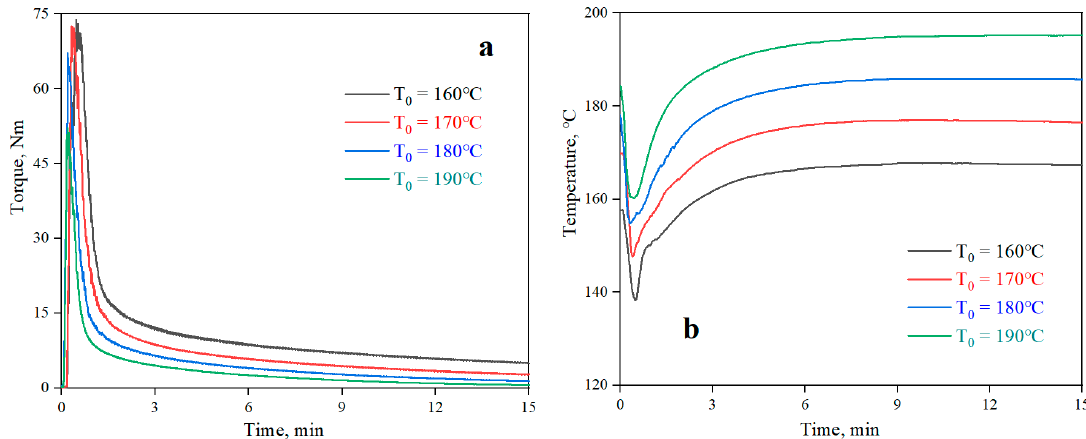
Figure 2. Torque ( a ) and temperature ( b ) versus time when processing the neat PLA at different chamber wall temperatures.